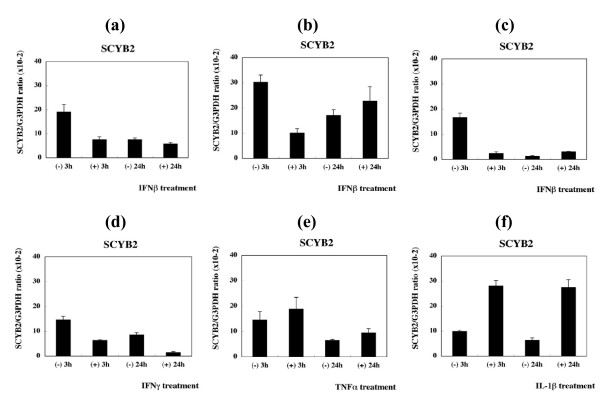
Real-time RT-PCR analysis of SCYB2 expression in PBMC. See the footnote of Figure 1. The panels represent the expression of SCYB2 in (a) #1, IFNβ; (b) #2, IFNβ; (c) #3, IFNβ; (d) #1, IFNγ; (e) #1, TNFα; and (f) #1, IL-1β.